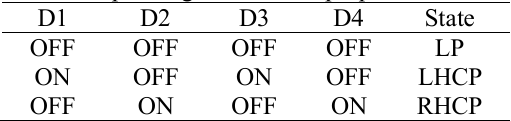
Table 1: Operating states of the proposed